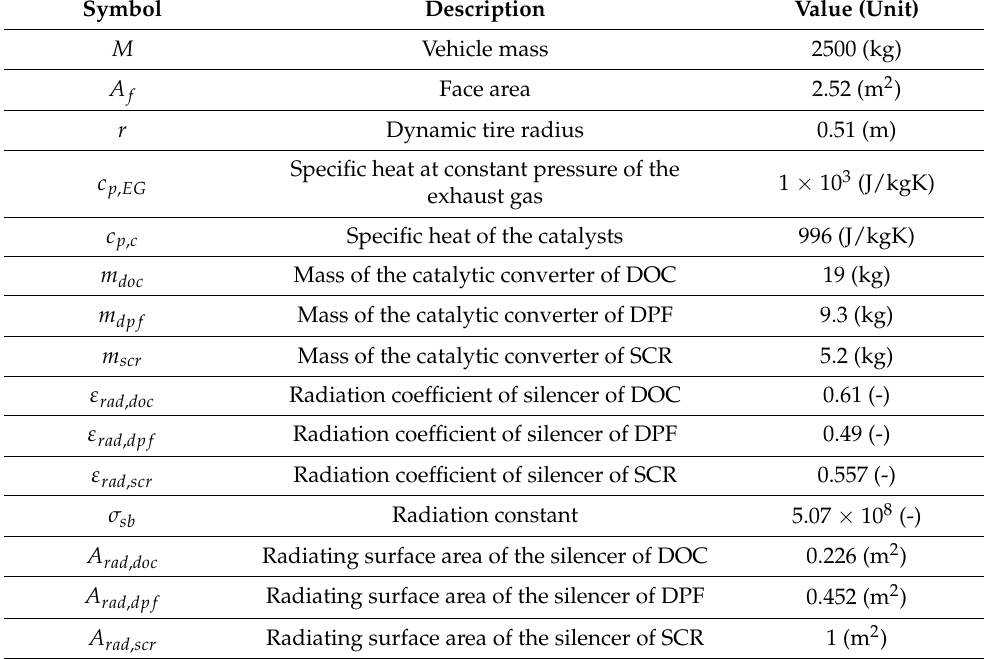
Table 1. Constants nomenclature of the DHEV vehicle